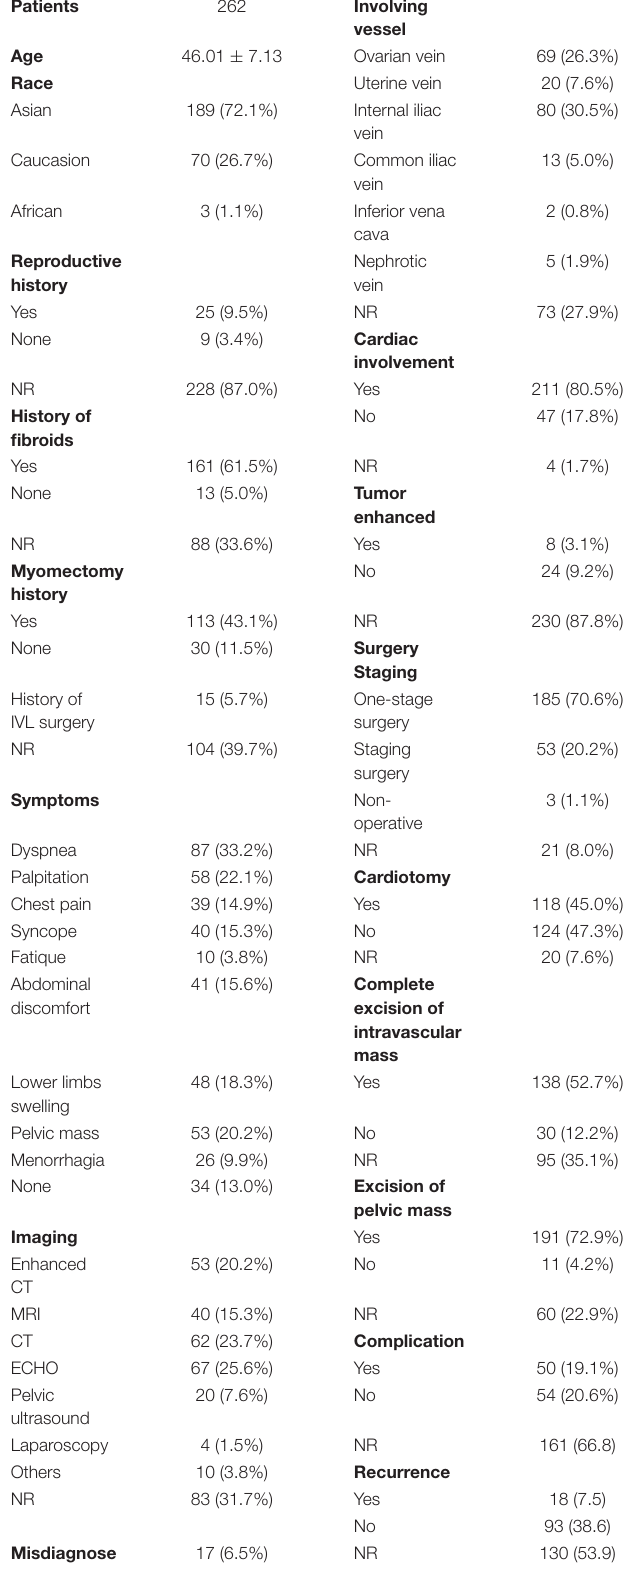
TABLE 2 | Summary of the clinical information of 262 patients with